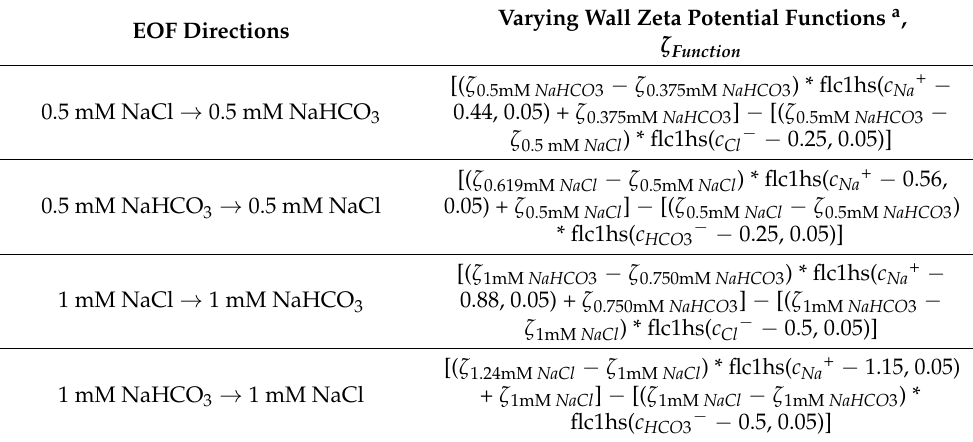
Table 7. Varying wall zeta potential functions for different EOF directions. Arrow indicates EOF